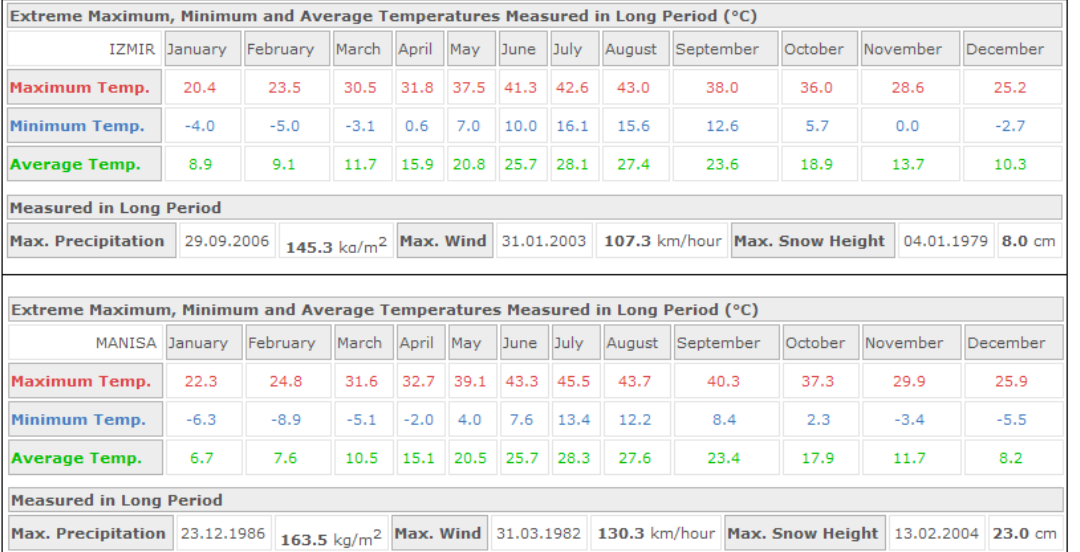
Figure 6. Seasonal weather data for Izmir and Manisa [59,60]